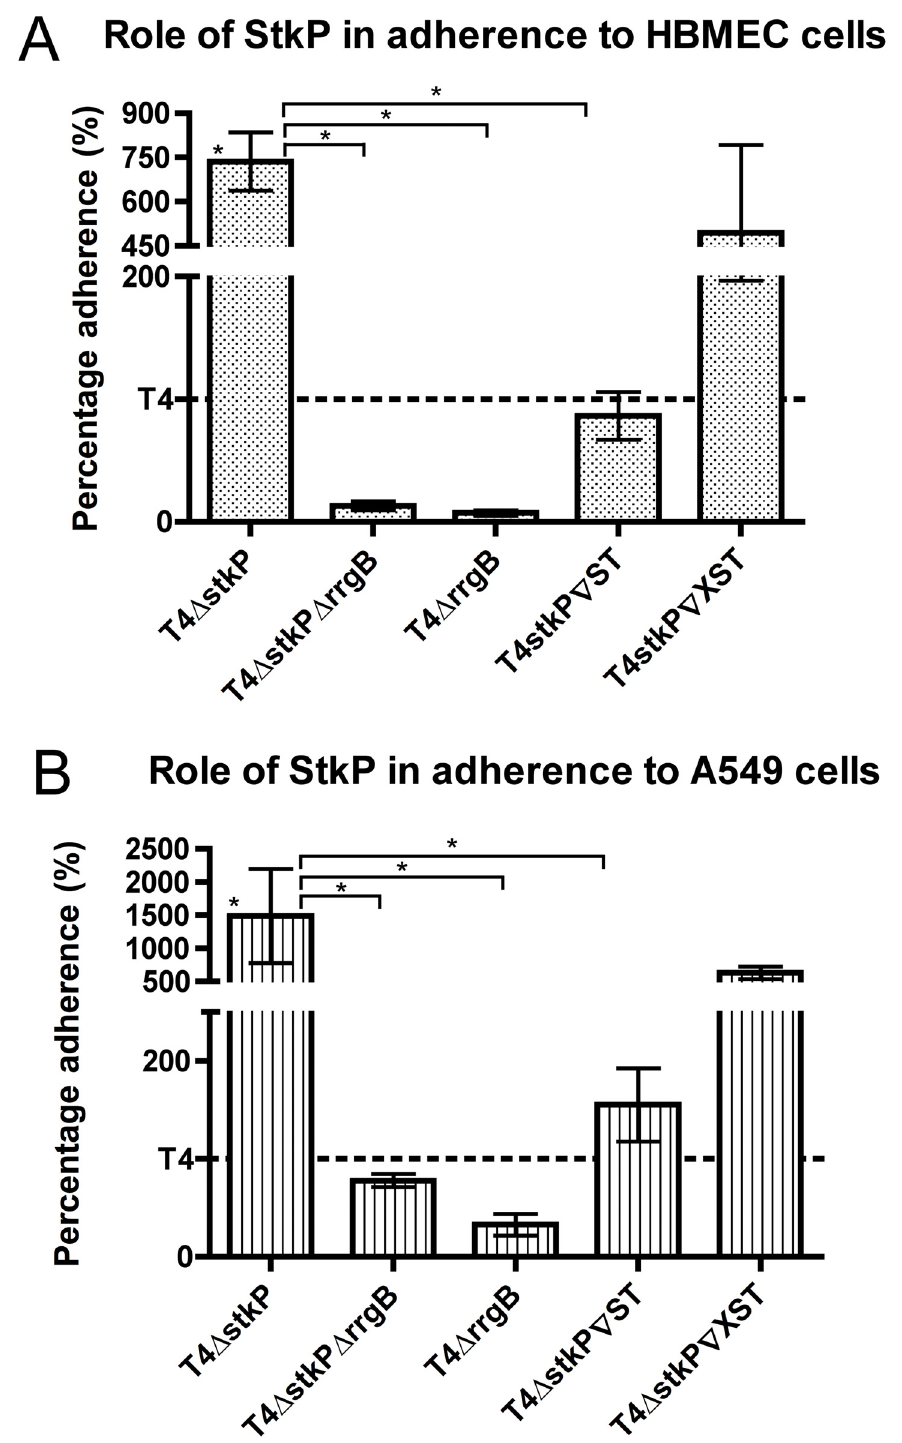
Fig 5. Adherence of T4 Δ stkP and StkP complemented strains to different cell lines. Adherence of strains TIGR4, T4 Δ stkP , T4 Δ stkP Δ rrgB , T4 Δ stkP r ST, T4 Δ stkP r XST and T4 Δ rrgB was assessed to HBMEC (A) and A549 (B) cell lines. Data is represented as percentage adherence relative to that of TIGR4 (100%, dashed line), each bar is an average of three replicas and the error bars represent the standard error of the mean. Statistical analysis was performed using a 1-way ANOVA with a Tukeys testing correction, * P < 0.05. * above the bar represent statistical significance compared to TIGR4 (not represented as a bar on the graphs).